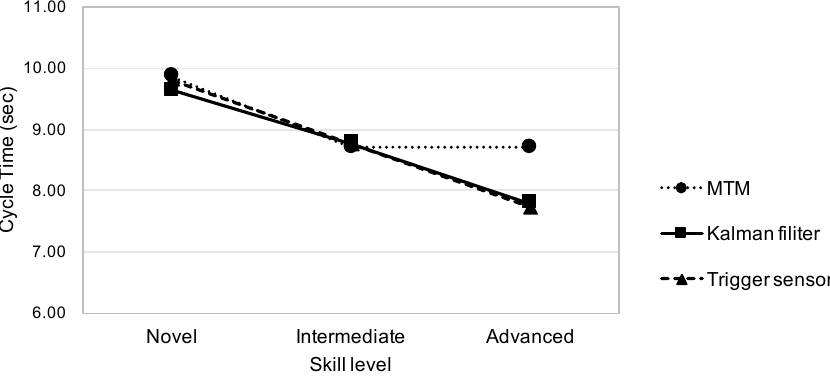
Figure 5. Average cycle time for three skill levels and handover prediction models.